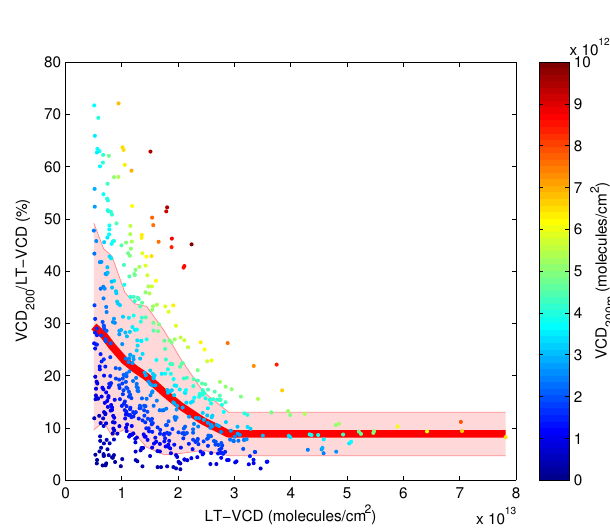
Figure 8. The relationship between the total BrO activation, as mea- sured by the LT-VCD, and the vertical structure of the activation event. The red line represents the mean percentage of BrO in the lowest 200m as a function of the LT-VCD, calculated from deciles on the x axis, while the shaded region represents one standard devi- ation. The coloration indicates the VCD 200m . In this plot LT-VCD values below 5 × 10 12 moleculescm − 2 are eliminated to avoid cal- culating percentages from near zero amounts of BrO.